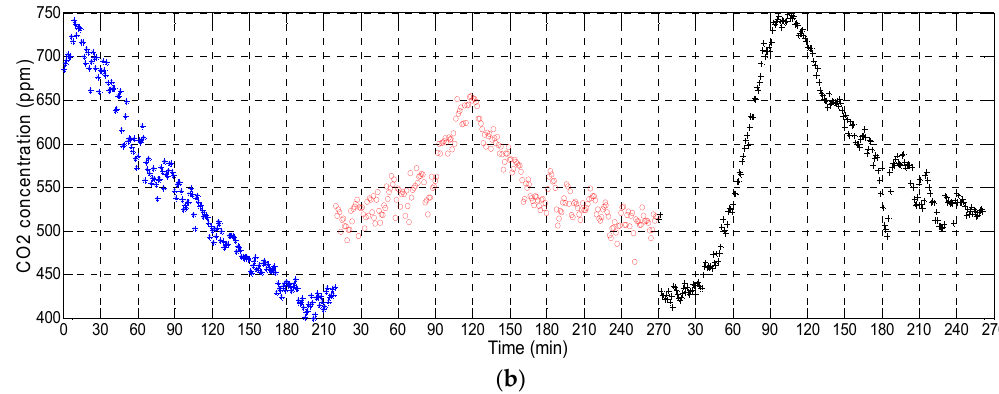
Figure 6. ( a ) Relative humidity acquired during laboratory sessions; ( b ) CO 2 concentration acquired during these same periods. Table 1. Packet Error Ratio.